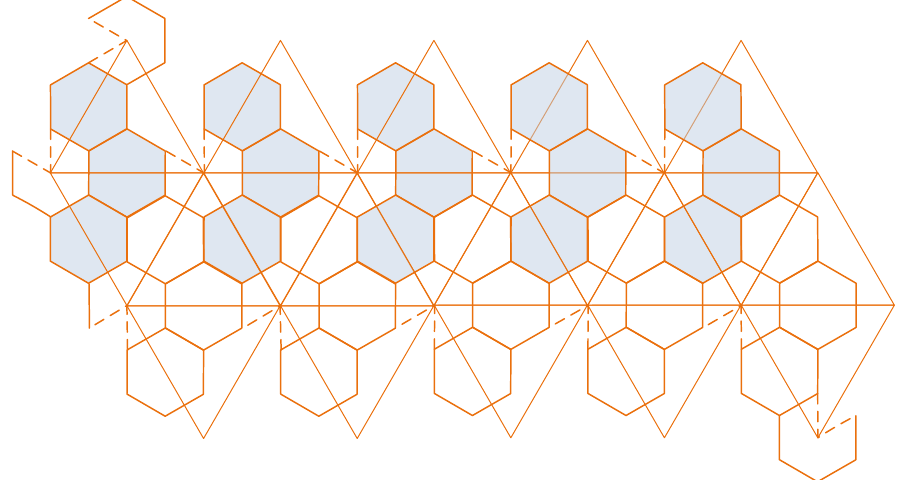
Figure 1. The first level hexagonal and pentagonal cells on the icosahedron.